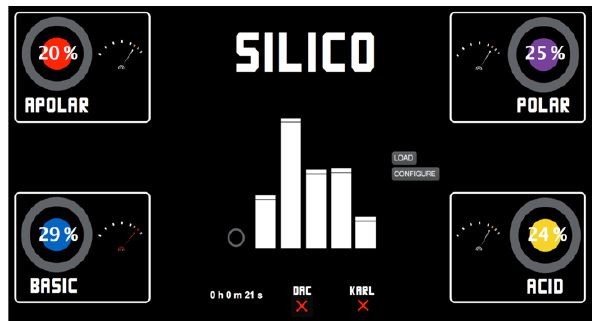
Figure 3. Silico’s